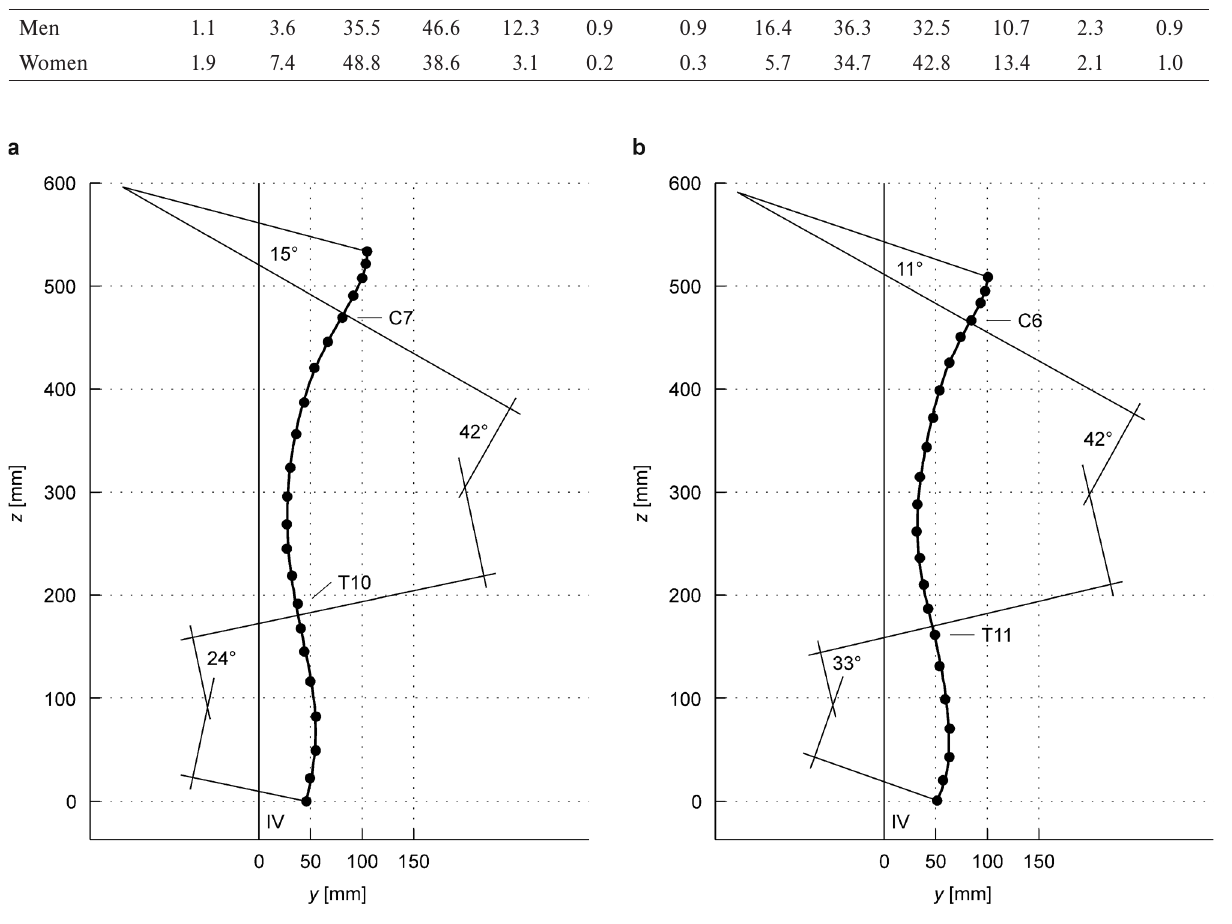
Percentage of cervicothoracic and thoracolumbar junctions occurrences Cervicothoracic junction Thoracolumbar Sex